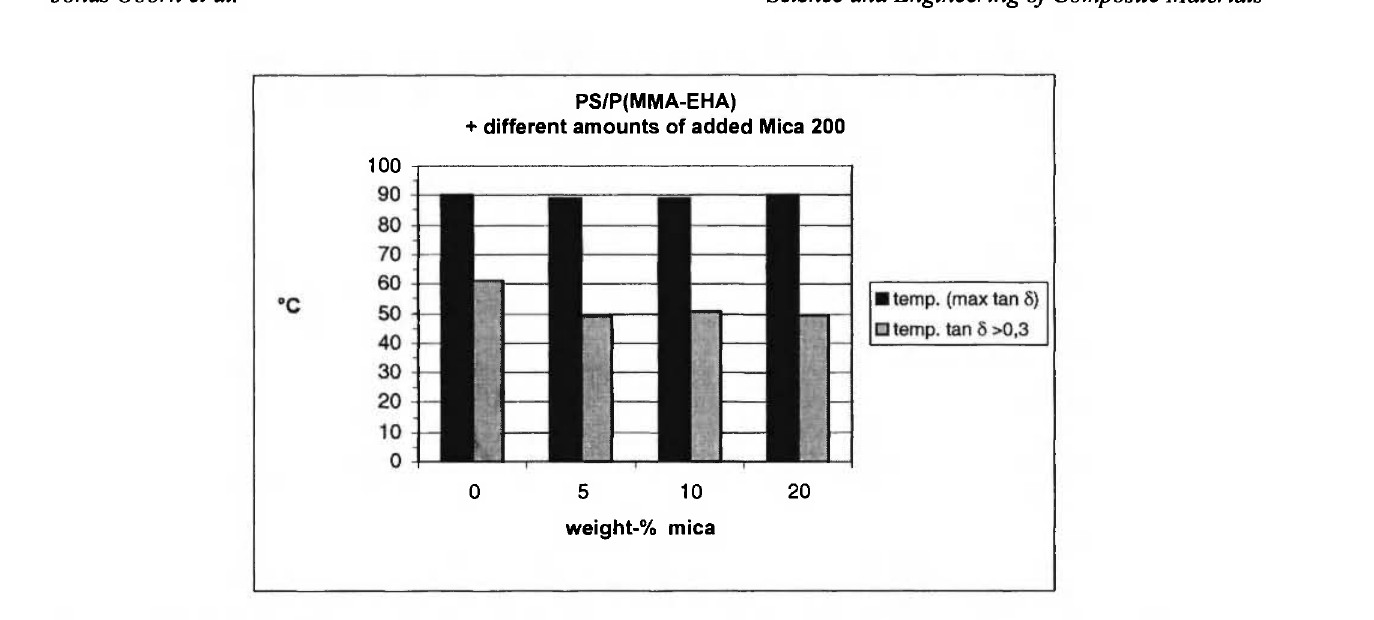
Fig. 3: Influence of amount of added Mica 200 on the damping temperature properties of PS/P(MMA-EHA), DMA measurements at 1 Hz.